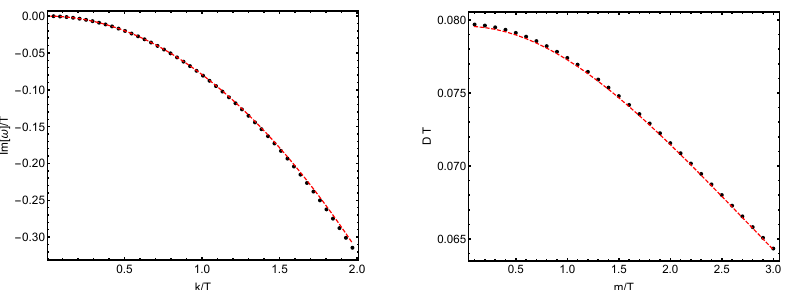
Figure 10 . Left: the shear di(cid:11)usion mode in the transverse spectrum of the (cid:13)uid model (4.1). The red dashed line is the hydrodynamic formula (4.4). We (cid:12)x the dimensionless SSB parameter to m=T = 0 : 148. Right: the shear di(cid:11)usion constant in function of the dimensionless parameter m=T . The dashed line indicates the approximated formula